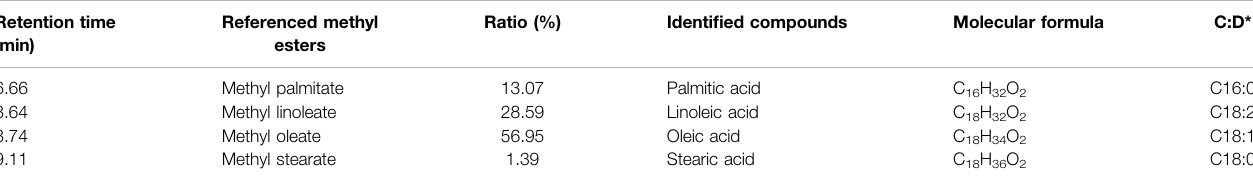
TABLE 5 | Major lipid compositions of AB-SCF.